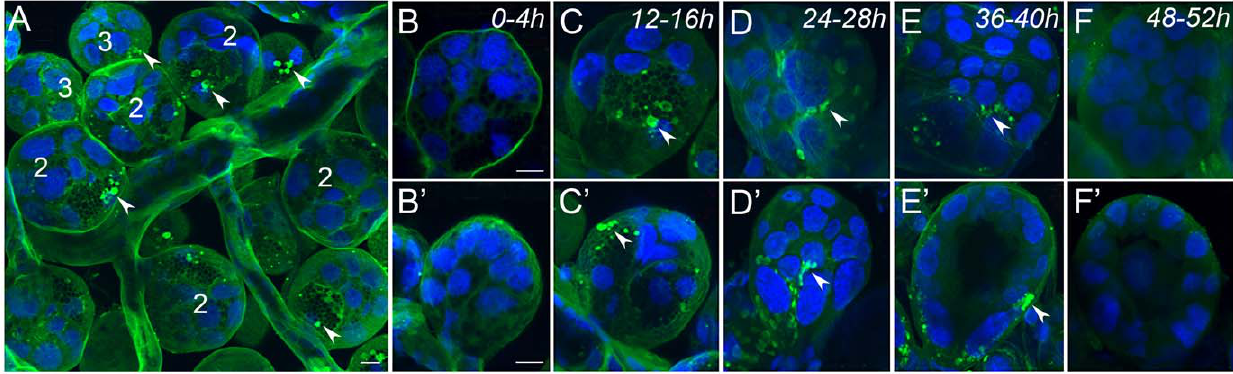
Figure 2. Dopamine immunoreactivities in the salivary glands of female ticks during various feeding phases. (A) A region of salivary glands with clustered acini II (labeled 2) and III (labeled 3) at 12–16 h after attachment. (B to F) Acini II at 0–52 h after attachment to the host and (B’ to F’) acini III at the same feeding 4ases. Note that positive staining (green marked with arrowheads) was detected in both acini II and III in the vesicles and their surrounding regions, but only at 12–40 h post-attachment. The blue color shows nuclei stained with DAPI. The images are composites of multiple confocal layers of thicknesses of 20 m m (A) or 2–5 m m (B to F’). Scale bars equal 10 m m.